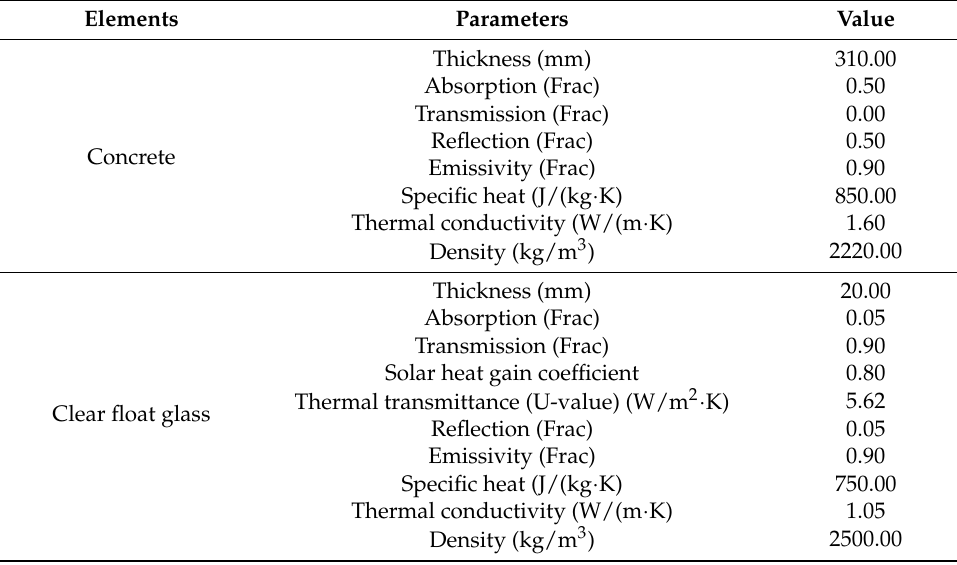
Figure 2. The six window-to-wall ratio (WWR) scenarios in this study.